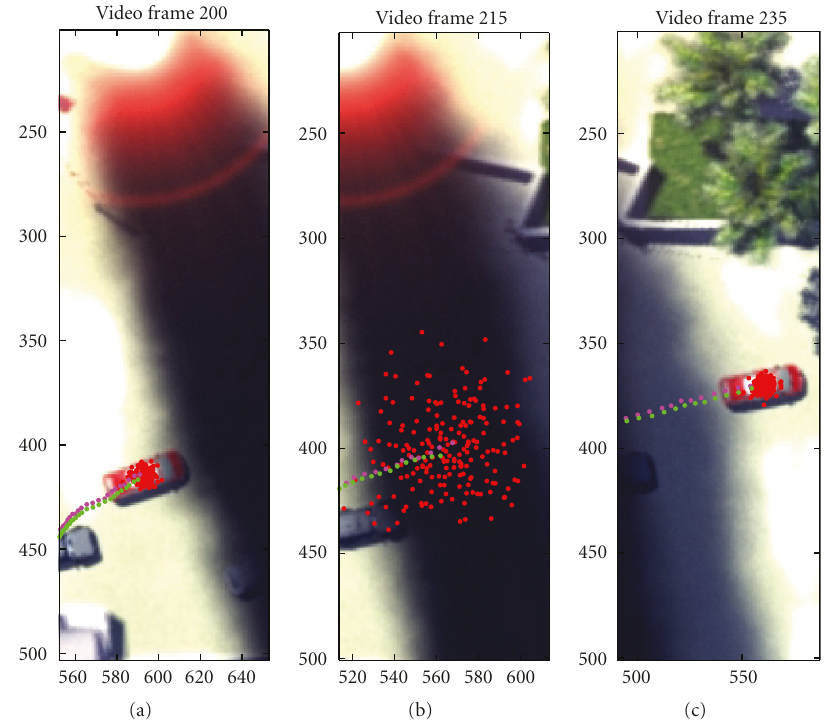
Figure 7: A sequential series of frames showing the distribution of particles (in red) and MAP position estimate (in green) as the vehicle enters and emerges from the thick smoke occlusion. The posterior distribution of the vehicle’s position increases significantly as it enters the occlusion. Magenta dots show the true vehicle’s path projected onto the respective video frames.